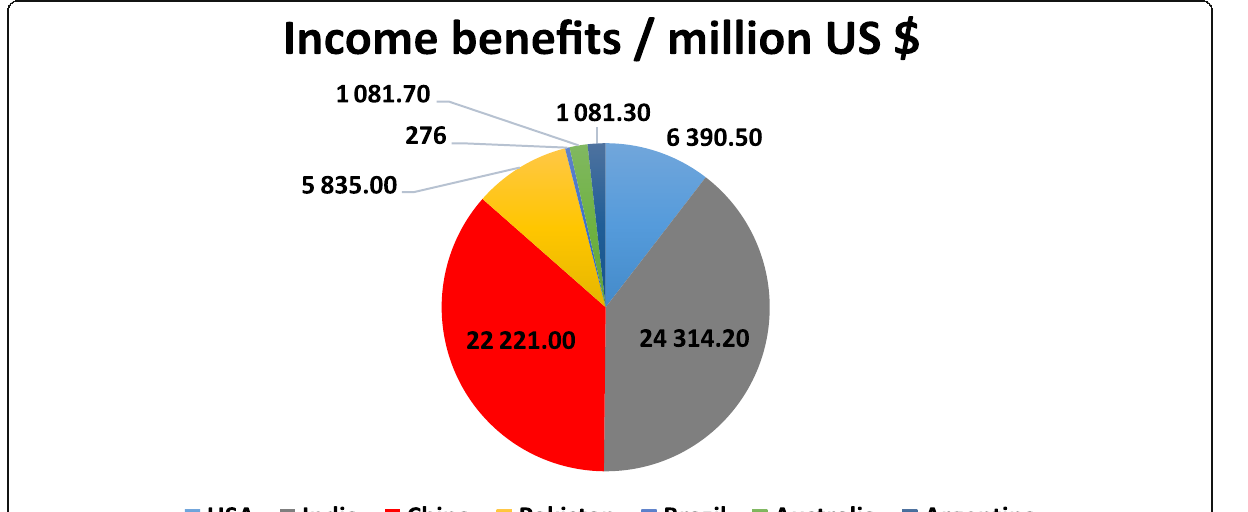
Fig. 3 Income benefits of genetic modified (GM) cotton farm in selected countries, 1996 – 2016 (million US$) (Brookes and Barfoot 2020a,